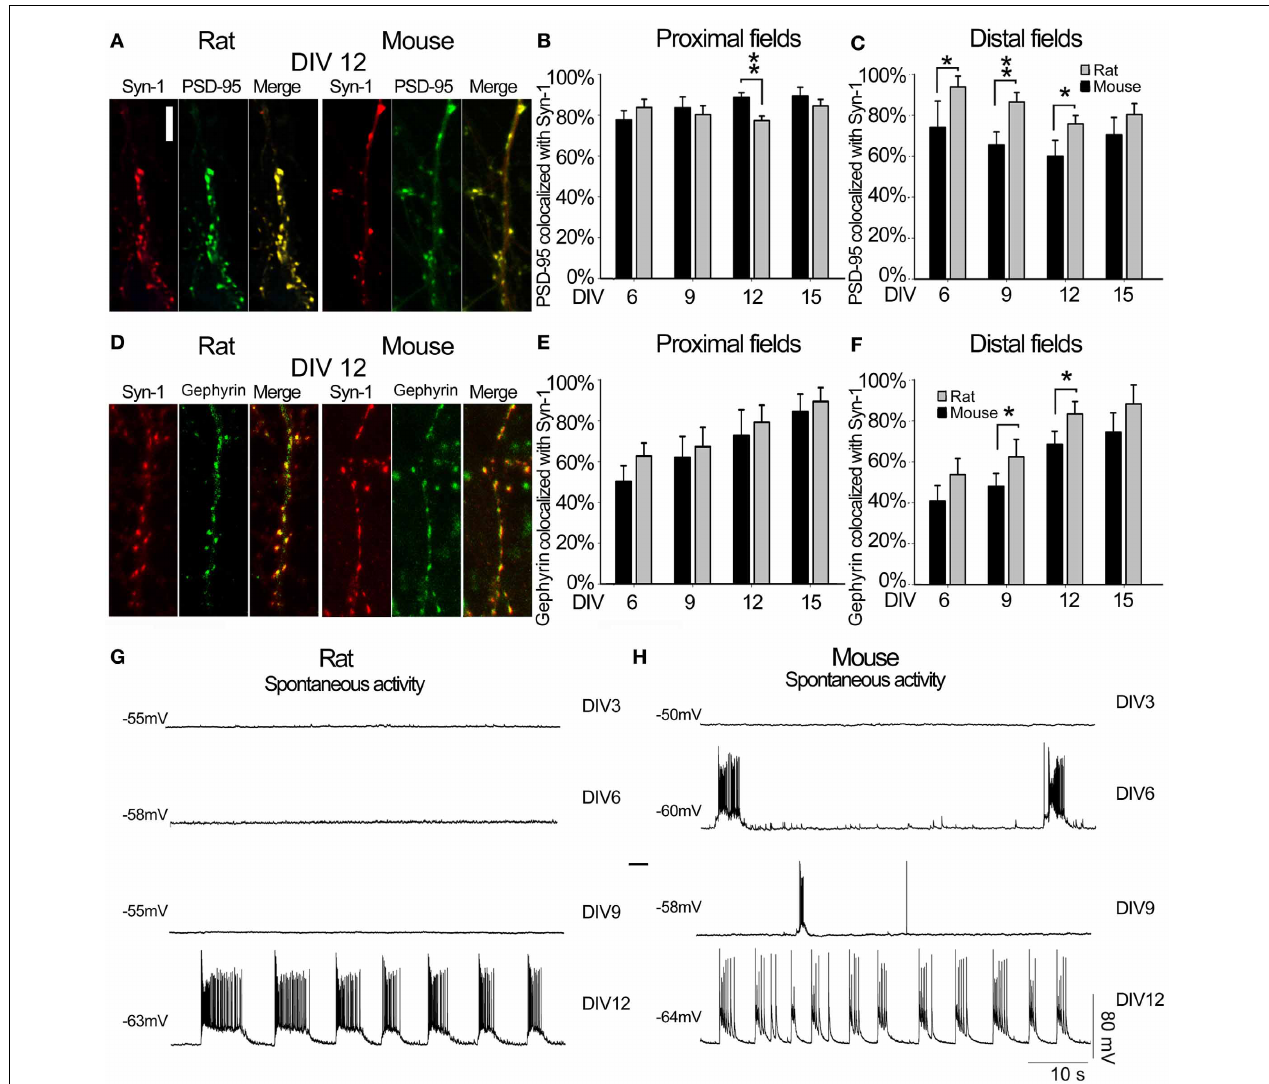
FIGURE 4 | Synapse characterization. (A) Representative image of SYN1 (red panel) and PSD95 (green panel) signals, and co-localization (merge panel) at DIV12 in rat and mouse hippocampal neurons (Scale bar = 5 µ m). (B) Quantitative data representing the degree of co-localization between the two synaptic proteins Rat (gray) and Mouse (black) in proximal dendritic fields. In the Y-axes, the percentages of colocalized PSD95 with respect to the total PSD95 signals were plotted, while the X-axes reports the different time points considered as DIV. (C) Quantitative degree of co-localization between PSD95 and SYN1 in distal dendritic fields. (D) Representative image of SYN1 (red panel) and